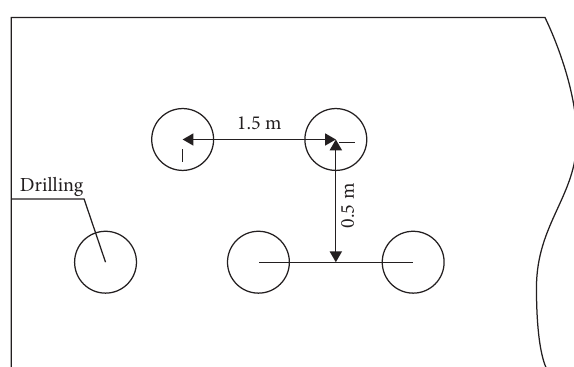
Figure 3: Layout of pressure relief hole.